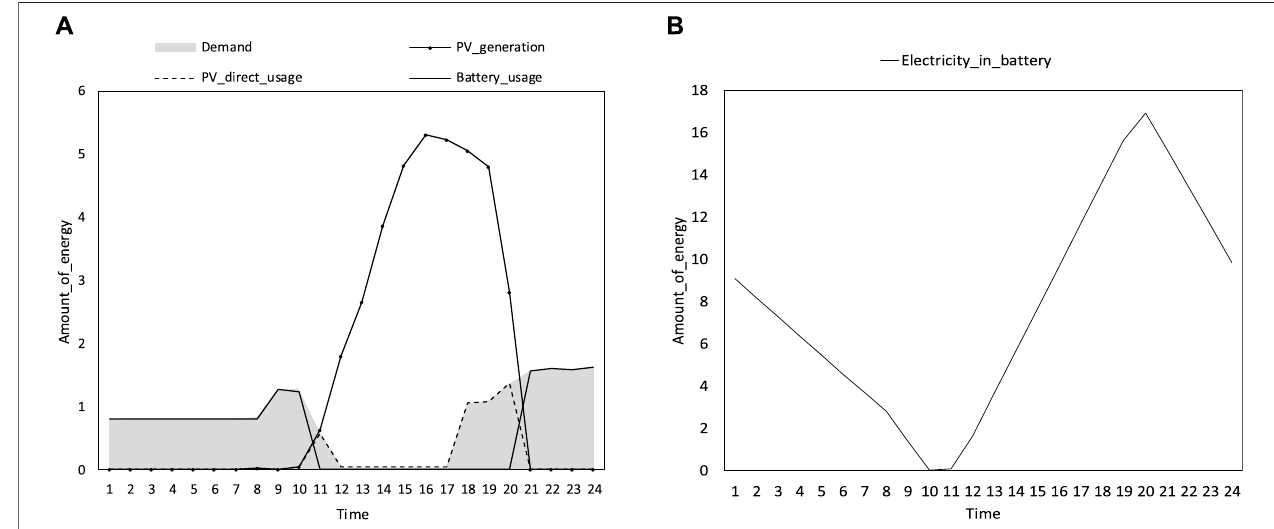
FIGURE5 | Hourly simulationresults on 6th August using the traditional method ofsizing devices(with 62 m 2 area, 26 ° PVinstallation angle, and 56 kWh energy of the storage battery): (A) electricity demand, generation, and usage; (B) electricity in battery.